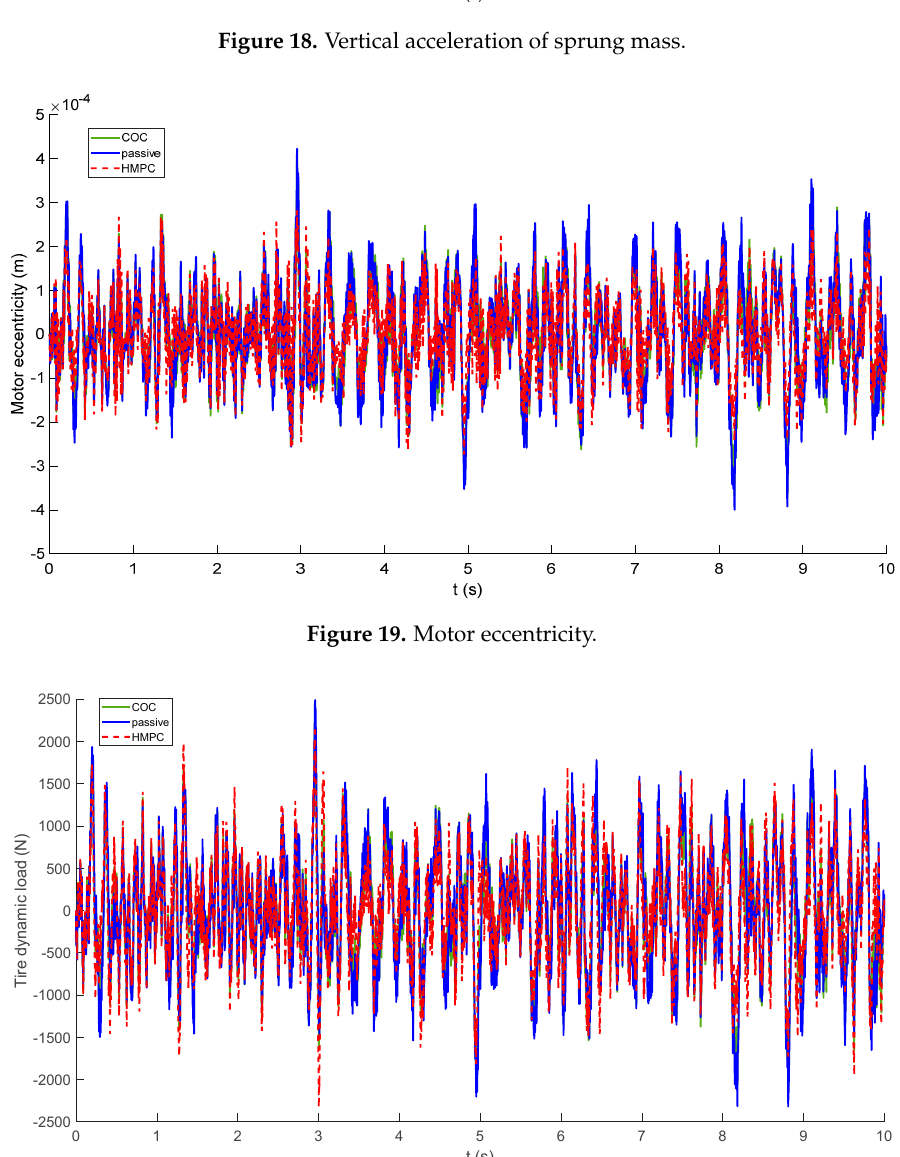
Figure 20. Tire dynamic load. Table 3. The RMS values of HM-EV evaluation index.